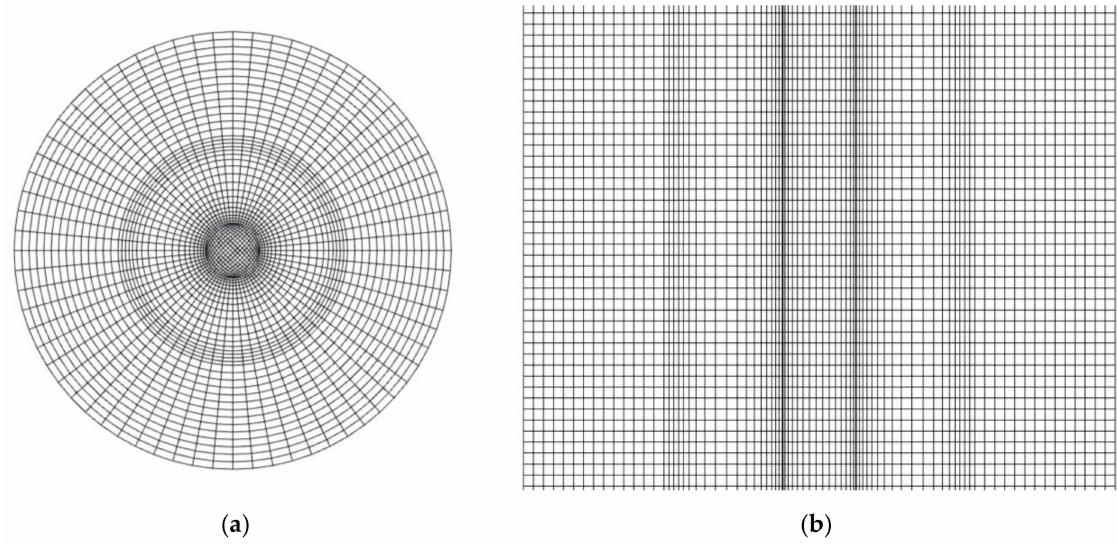
Figure 1. Mesh for bubble column simulation in Ansys Fluent. ( a ): View from the top ( b ): Section view from the